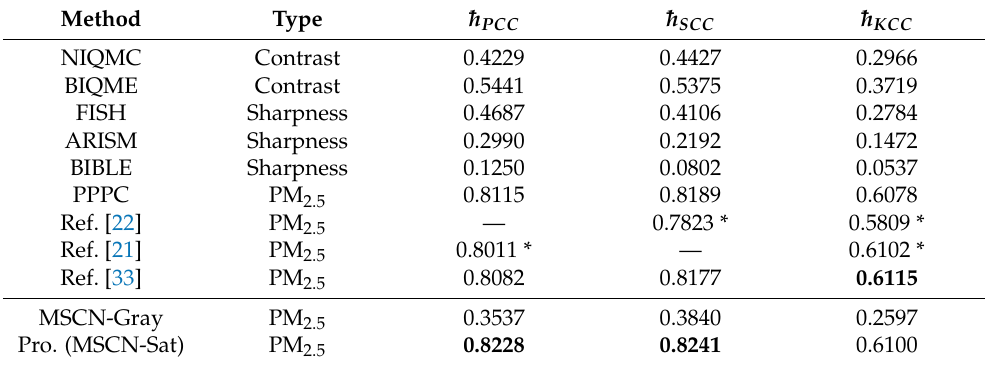
Table 3. Performance comparison of the picture-based PM 2.5 monitoring algorithms, the image contrast and sharpness measurement algorithms on the AQID. * denotes that the corresponding results are collected in the original